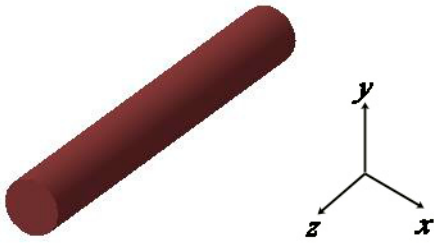
Figure 2. The simplified model of a branch.